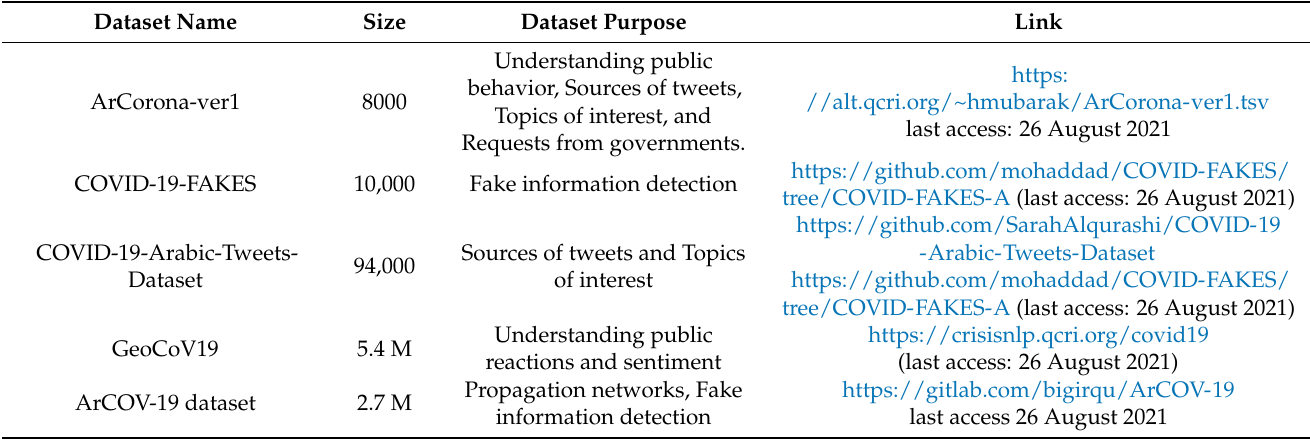
Table 2. Publicly Available Arabic Datasets.